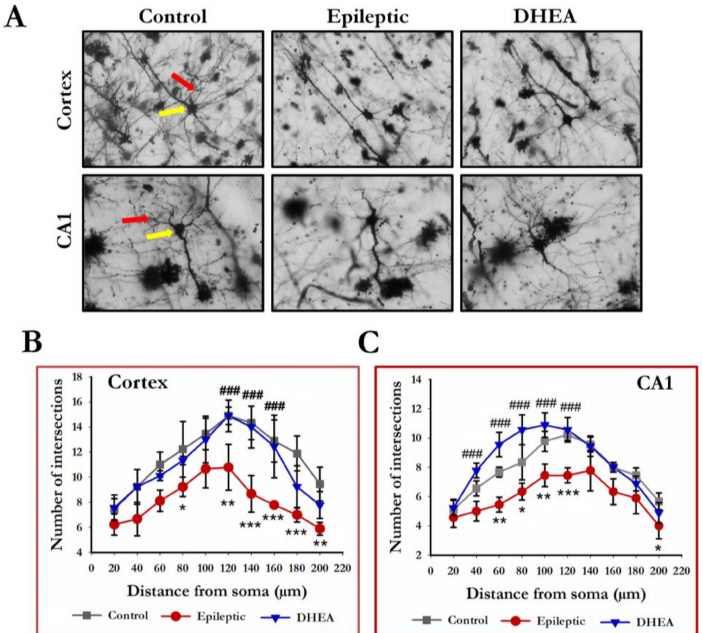
Figure 5. Dendritic arborization in the cortex and hippocampus of control, epileptic and DHEA- treated rats. Representative Golgi-Cox-stained neurons photomicrographs from the cortex and hippocampus captured under 40 × magnification showing dendrites (red arrows) and soma (yellow arrows) ( A ). Quantification of dendritic arborization by evaluating the total number of intersections at each concentric ring away from the soma in the cortex ( B ) and hippocampus ( C ) of experimental rats. Data are expressed as mean ± SD (n = 3 in each group). * p ≤ 0.05, ** p ≤ 0.01, *** p ≤ 0.001 significantly different from control group; ### p ≤ 0.001 significantly different from epileptic group.